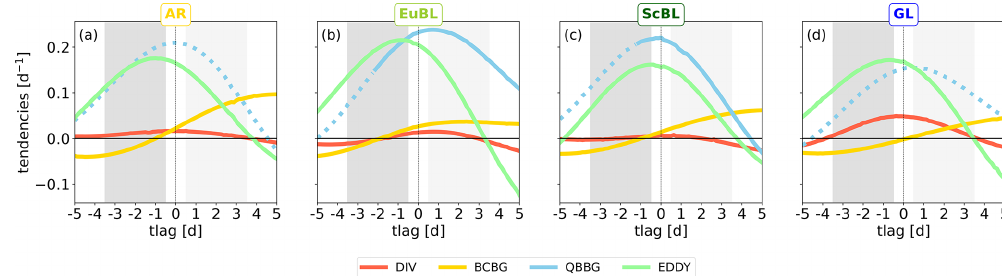
Figure 7. Piecewise PV tendencies projected onto the respective regime pattern for ± 5da around onset: (a) AR, (b) EuBL, (c) ScBL, and (d) GL. Blue: quasi-barotropic dynamics, dotted if intrinsic propagation (WAVE) dominates advection by the background flow (ADV), solid otherwise. Yellow: baroclinic coupling. Red: divergent tendency. Green: eddy flux convergence. Grey shading indicates the time periods that define the before-onset averages (dark) and after-onset averages (light) discussed as spatial maps, e.g., in Figs.